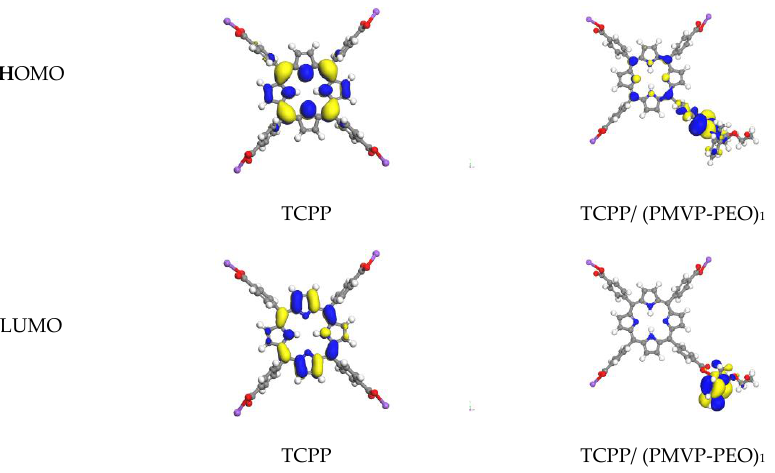
Figure 7. Molecular orbital diagrams calculated for TCPP and TCPP/ (PMVP-PEO) 1 . PMVP-PEO is an abbreviation of PMVP 41 - b -PEO 205